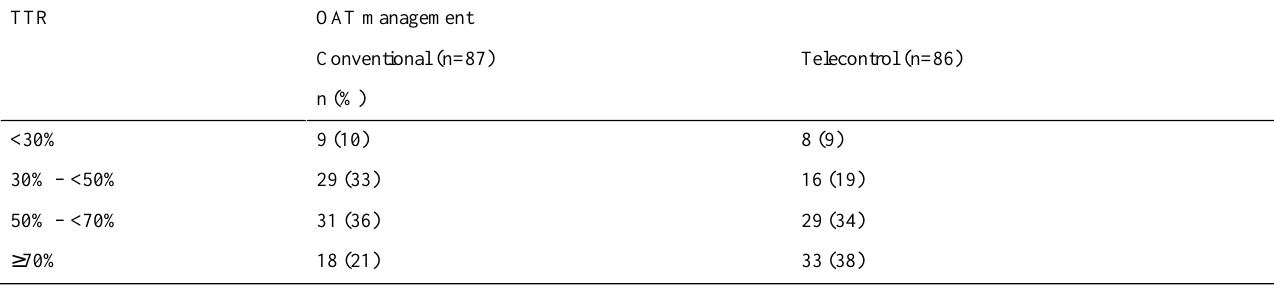
Table 3. Distribution of patients of the two oral anticoagulant therapy (OAT) treatment groups (conventional control and telecontrol with the